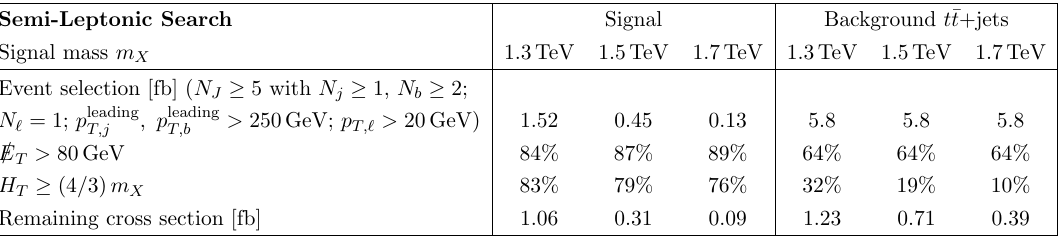
Table 1 . Cut (cid:13)ow for di(cid:11)erent resonance masses m X and dominant background t (cid:22) t +jets for the semi-leptonic search. All branching ratios are applied to signal and background when quoting cross sections. We normalize the signal assuming Br( X ! t (cid:22) t ) = Br( X ! JJ ) = 50%. Fully Leptonic Search Signal Background t (cid:22) t +jets Signal mass m X